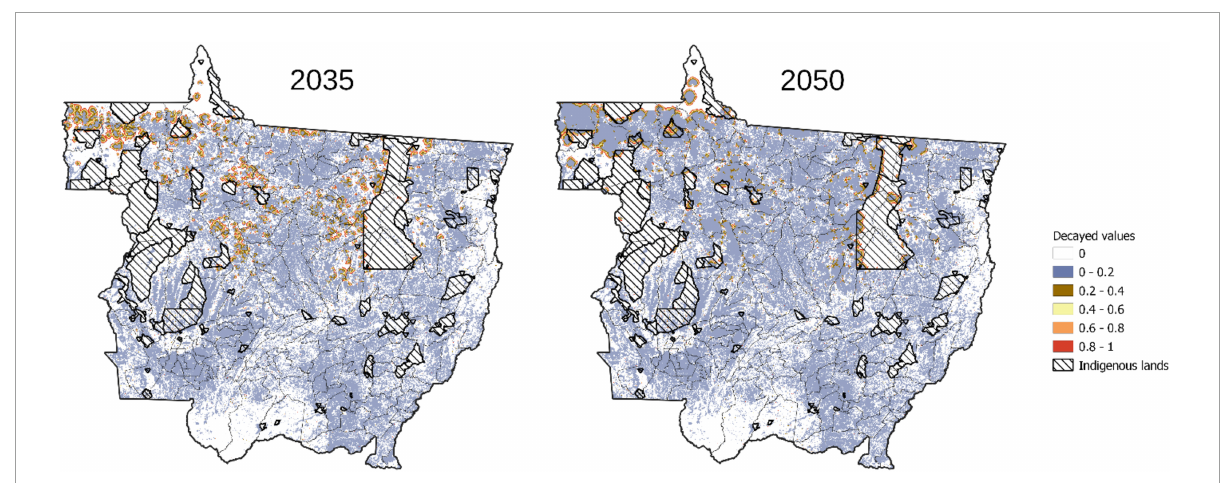
Figure 10 for the years 2035 and 2050. We see that in 2035 the deforestation process is still in an active stage. The hotspots are shown in magenta and red colors. In the future deforestation is happening mainly in the Amazon biome which can be explained by the historical deforestation pattern depicted in Figure 2 . In this figure most of the clusters of pixels with high decayed values in 2010, which drive the future dynamics in the model, are located in the Amazon biome. There are some recent deforestation events in Pantanal, but they are rather isolated, i.e., not forming clusters, and therefore do not activate the proposed neighboring mechanism intensively, leading to low deforestation in the future scenarios. As mentioned in the paper we do not model afforestation and therefore deforestation can happen only in the cells that were not deforested